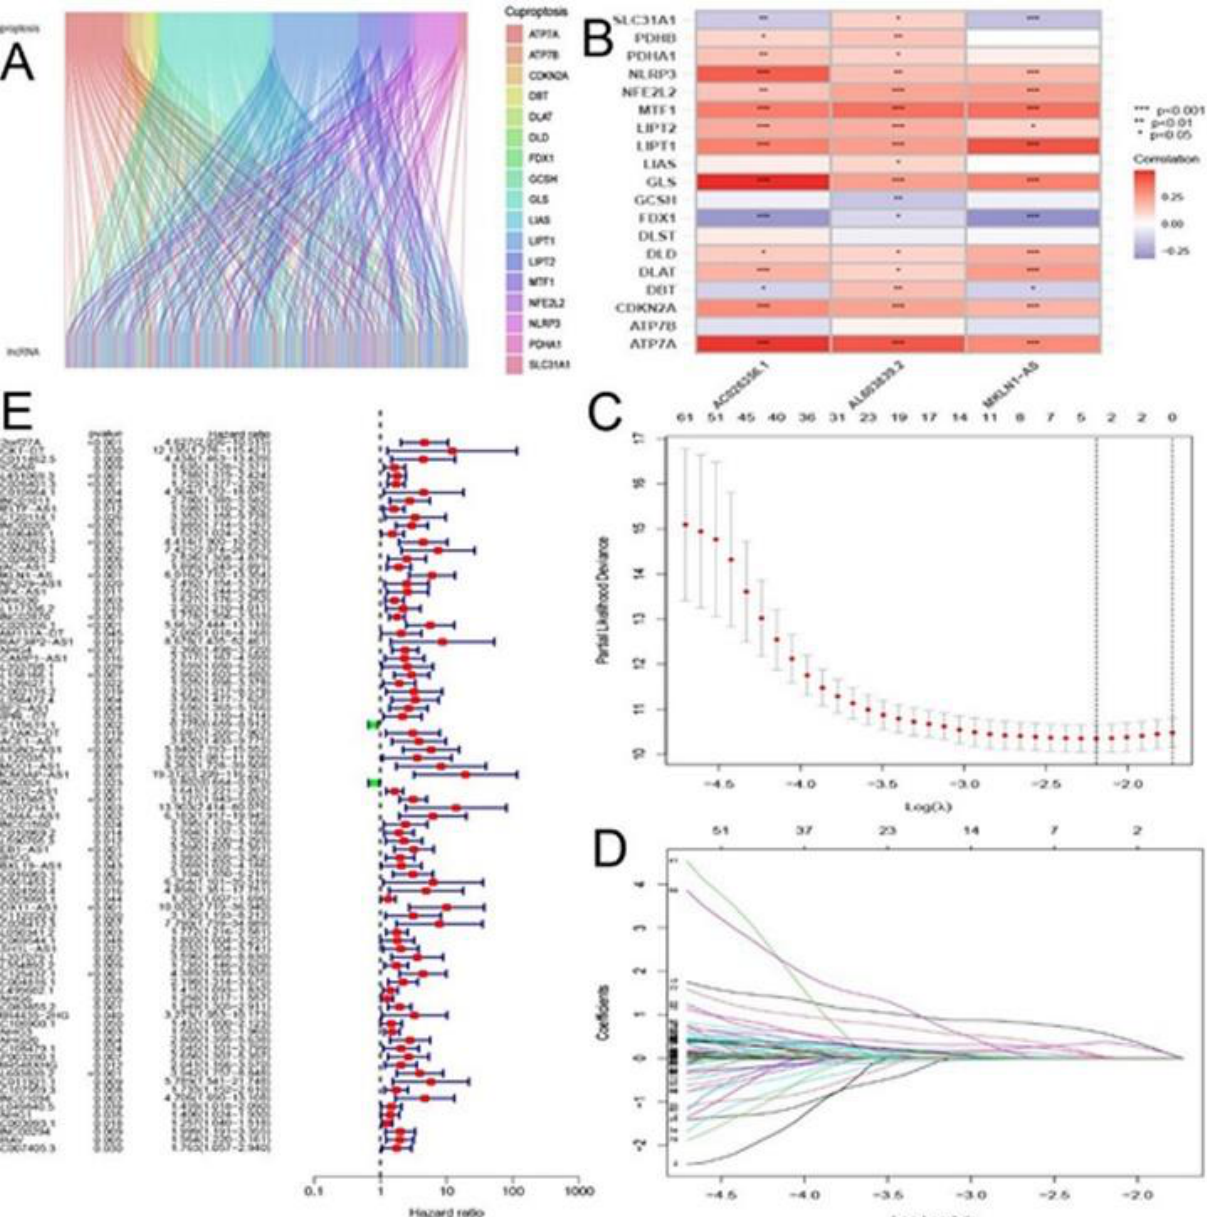
Figure 1: (A) Sankey relationship diagram of CuProtosis genes and LncRNAs; (B) Heat map of correlations between CuProtosis genes and 3 related LncRNAs involved in model construction. (C) Selection of tuning parameters (logλ) for OS-related proteins to cross-validate error curves. Draw a vertical imaginary line at the optimal value according to the minimum criterion and the 1-se criterion. (D) LASSO coefficient distribution and vertical imaginary line of OS-associated LncRNAs are plotted with the values selected by 10-fold cross-validation. (E) High and low risk lncRNAs. Red is high risk, green is low